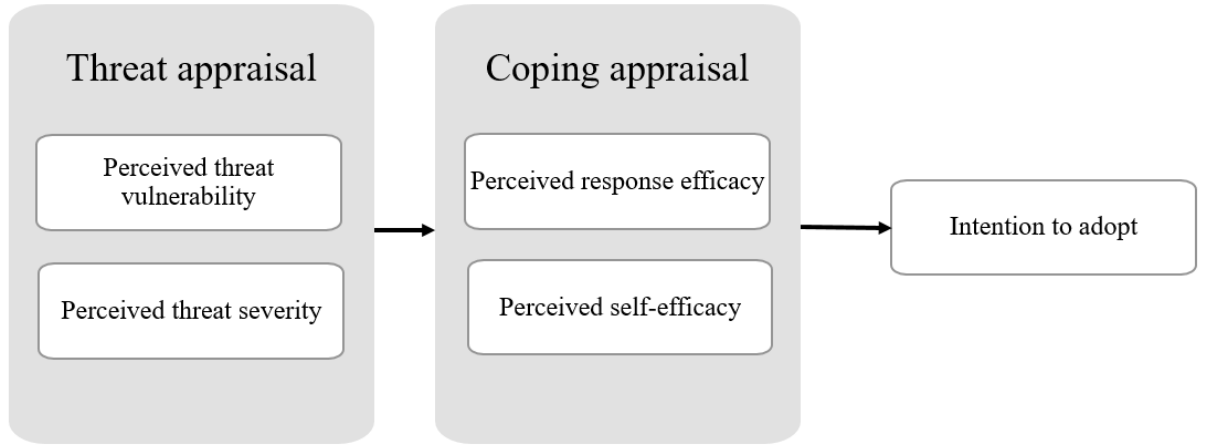
Figure 1. Protection motivation theory model.